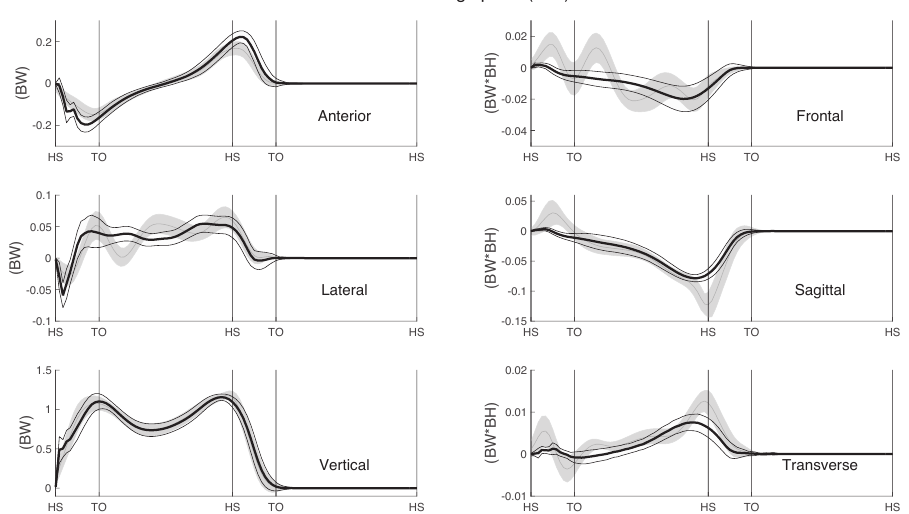
Figure 7. Ground reaction forces and moments (GRF&M) estimated using OMC (mean (thin grey line) ± 1 SD around mean (shaded area)), compared with measured FP data (mean (thick black line) ( ± 1 SD (thin black lines)) during normal walking. Curve magnitudes are normalized to body weight and body weight times body height for the GRF and GRM, respectively. Averaged over right and left steps of all 11